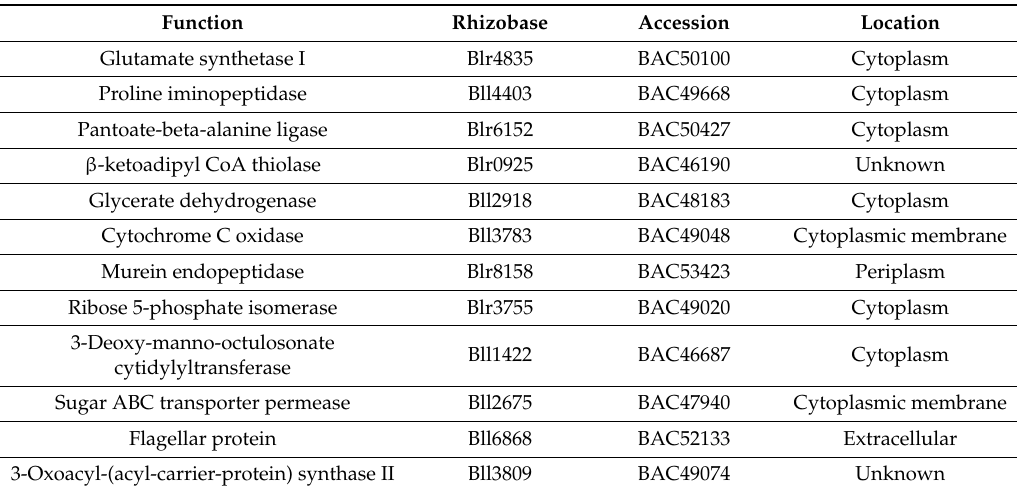
Table 3. Examples of B. diazoefficiens genes expressed during the senescence of soybean root nodules following the pattern displayed in Figure